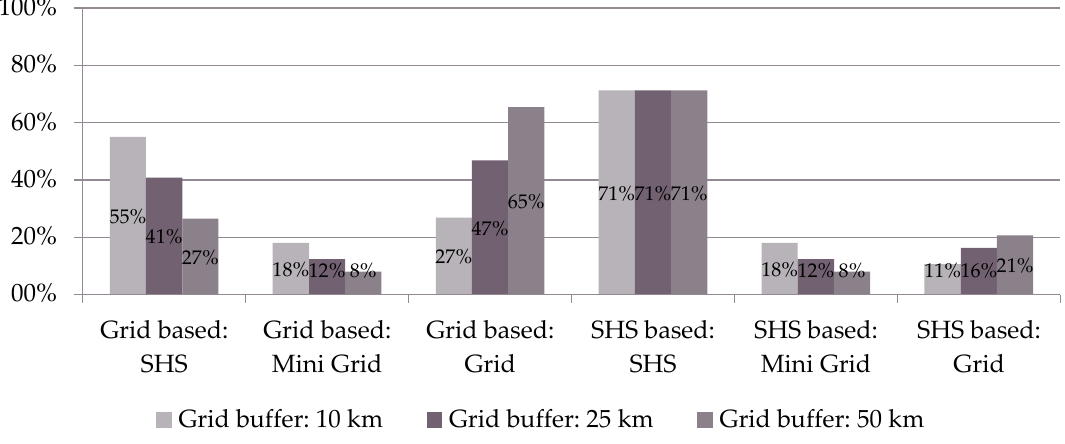
Figure 7. Results of sensitivity analysis for the parameter grid buffer radius. The bar diagram shows the results for all considered countries for a buffer radius of 10 km, 25 km (base scenario) and 50 km for grid based and SHS based scenarios.